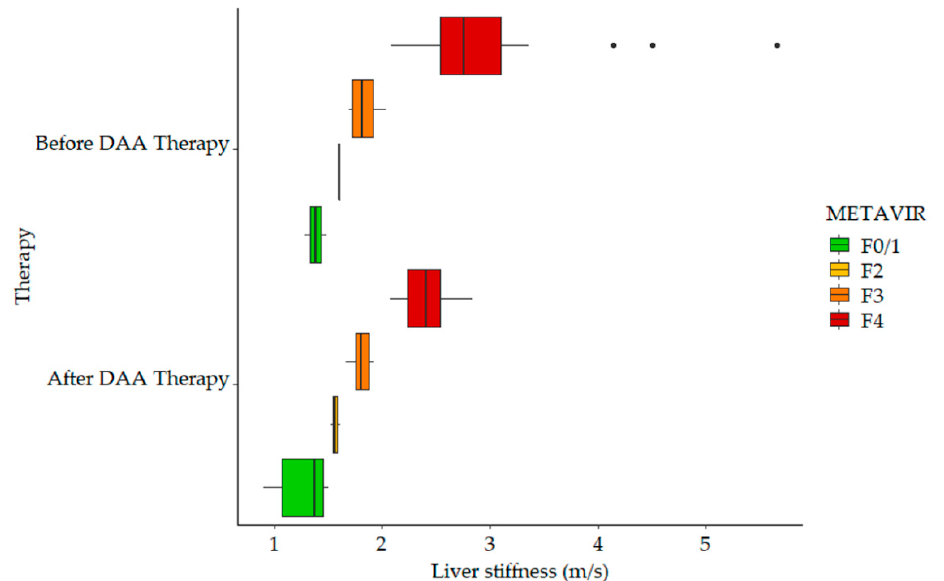
compared to the baseline (F0/1 = 2, F2 = 1, F3 = 7, F4 = 25) (Figure 4) (Table 1). The number of cirrhotic cases (F4) was also significantly lower (OR = 0.27, 95% CI = 0.09–0.72, p < 0.016) at EOT48w. The average decrease in LS was greater ( p < 0.028) in cirrhotic cases (F4, ∆ -LS = − 0.87 ± 0.79 m/s) than in non-cirrhotic cases (F0/1, ∆ LS = − 0.26 ± 0.37). The LS improved in 31 out of 35 patients in SVR, and it slightly increased in only four cases, including two cirrhotic and two F2 grade fibrosis patients (Figure 5).